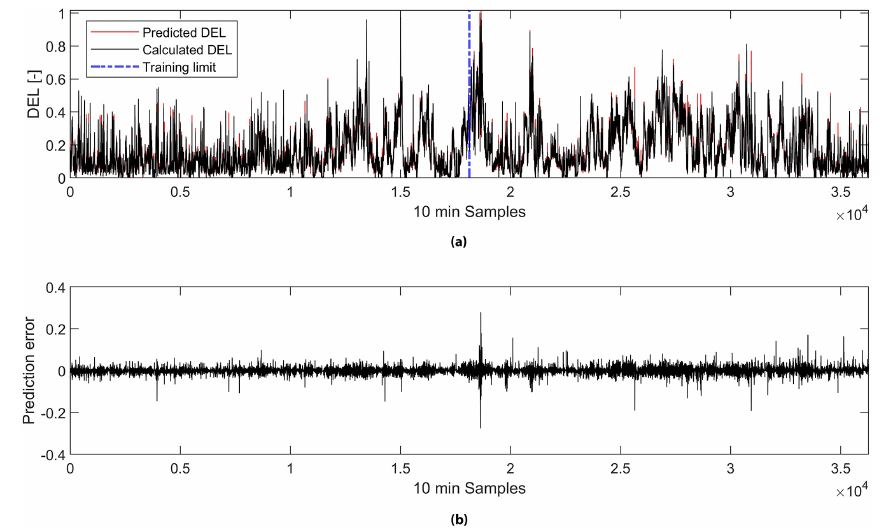
Figure 8. (a) A comparison of normalized predicted and measured DELs and (b) the corresponding prediction error for the model using the feature set from the correlation analysis.